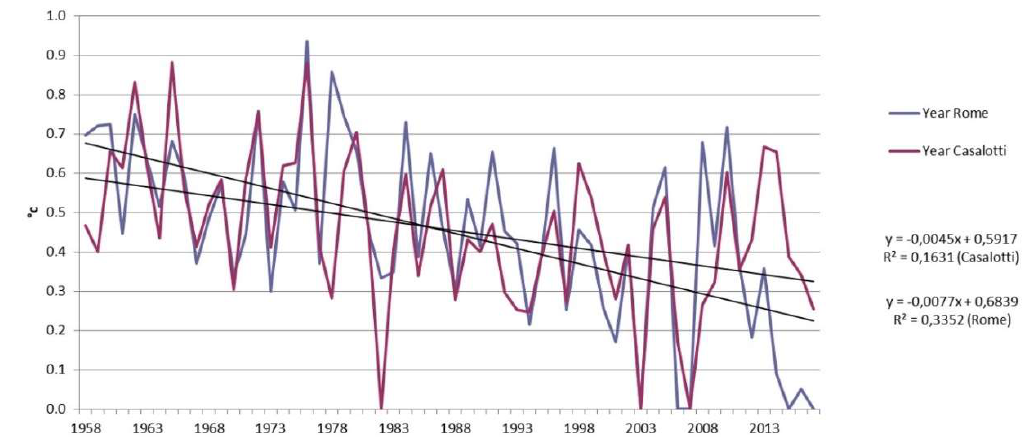
Figure 8. Trends over time in a composite index of climate aridity incorporating standardized precipitations and temperatures.